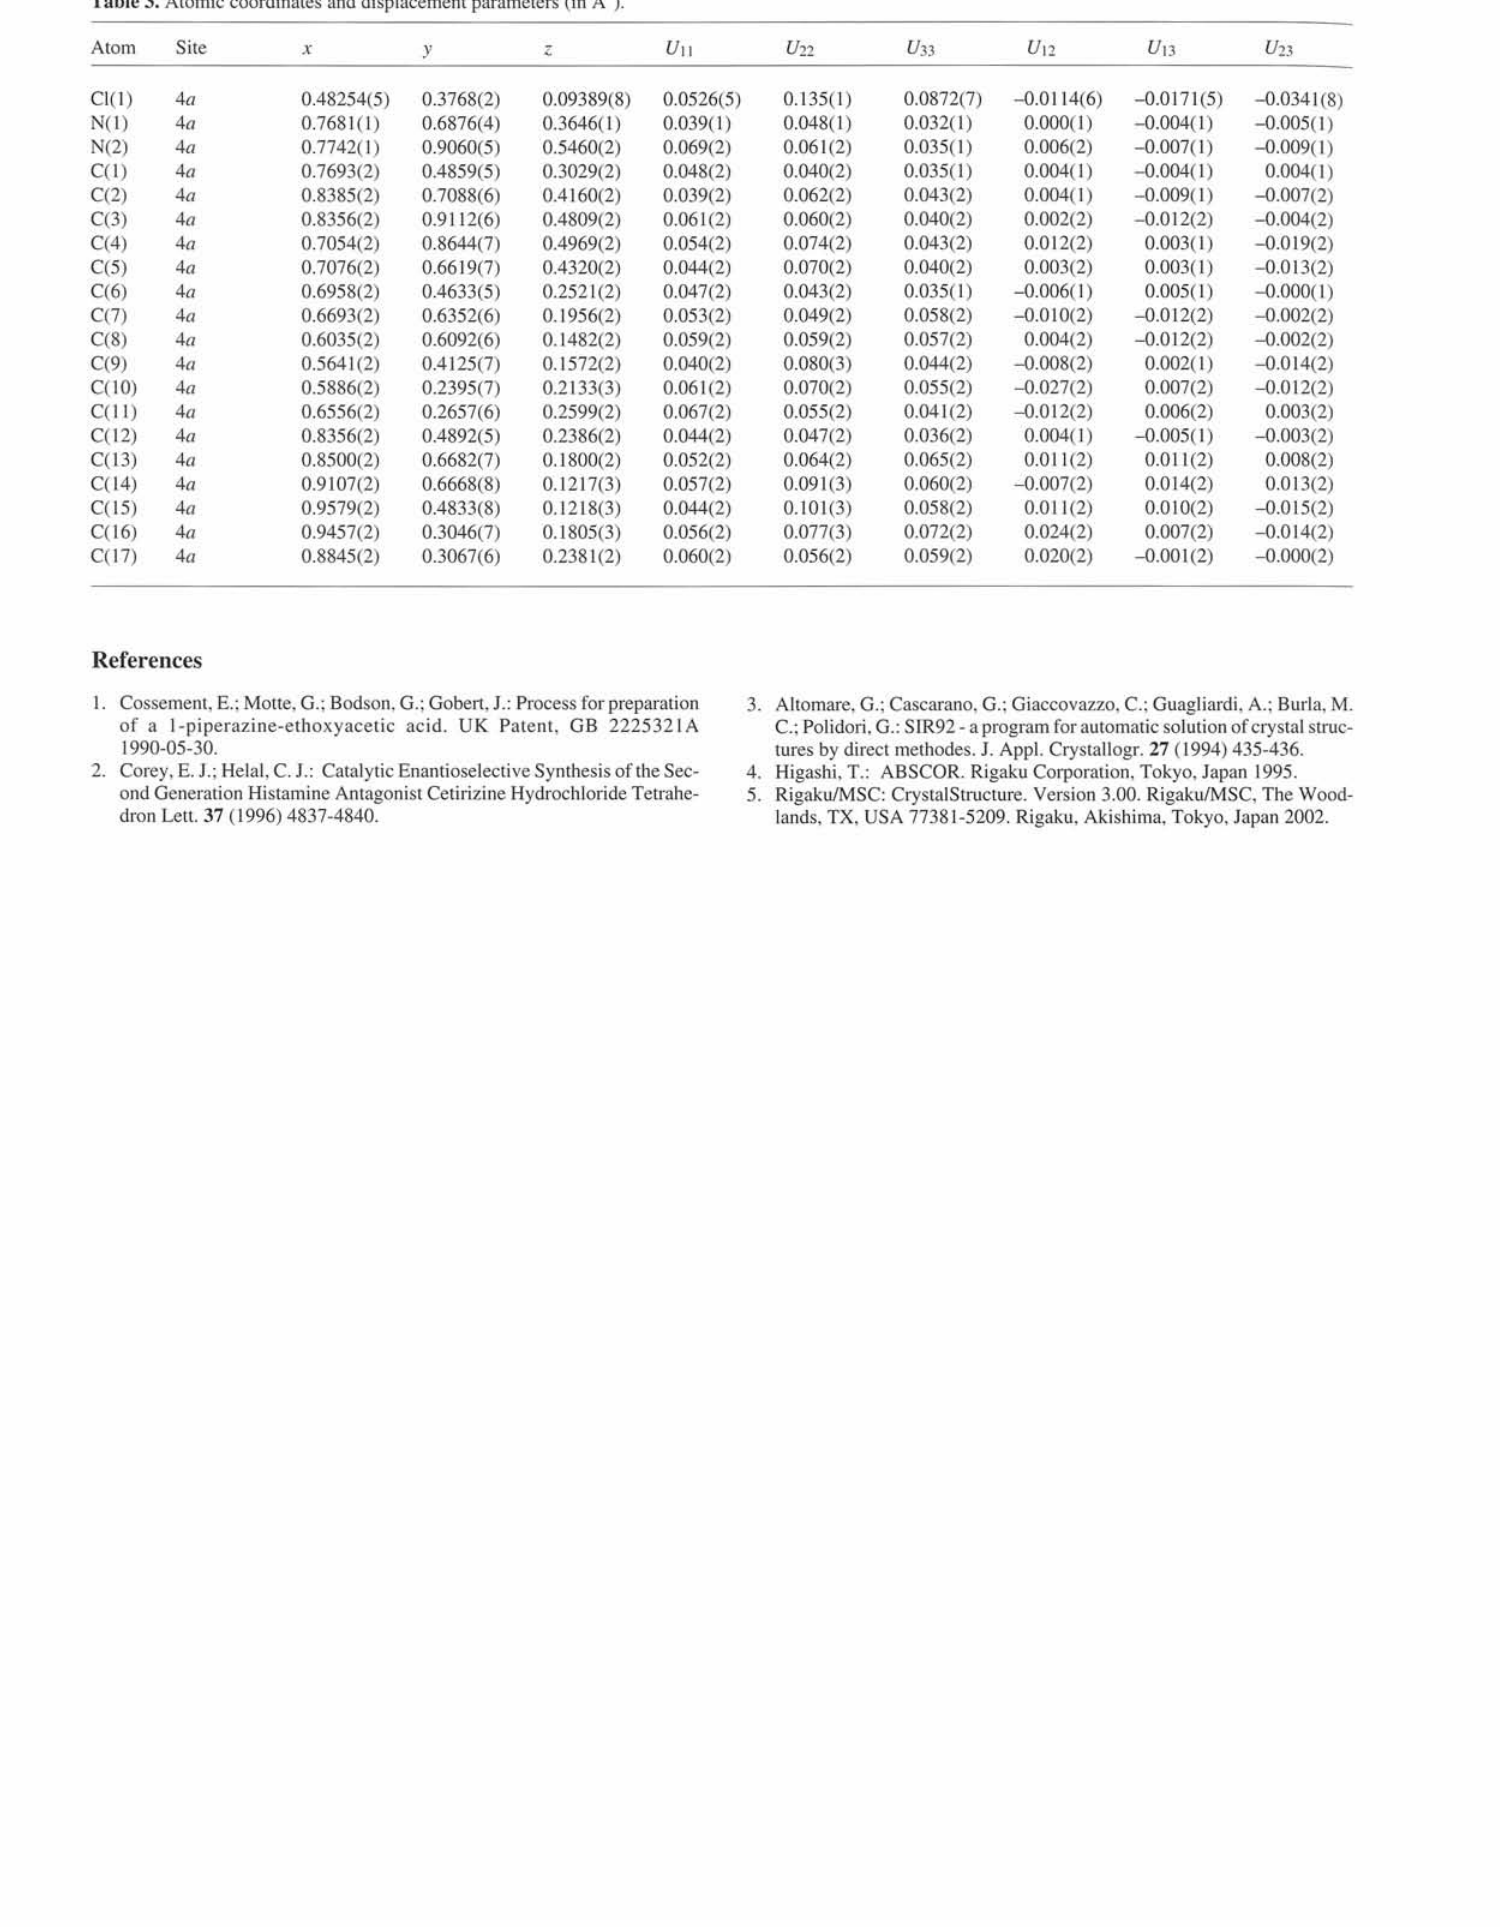
Table 3. Atomic coordinates and displacement parameters (in À 2